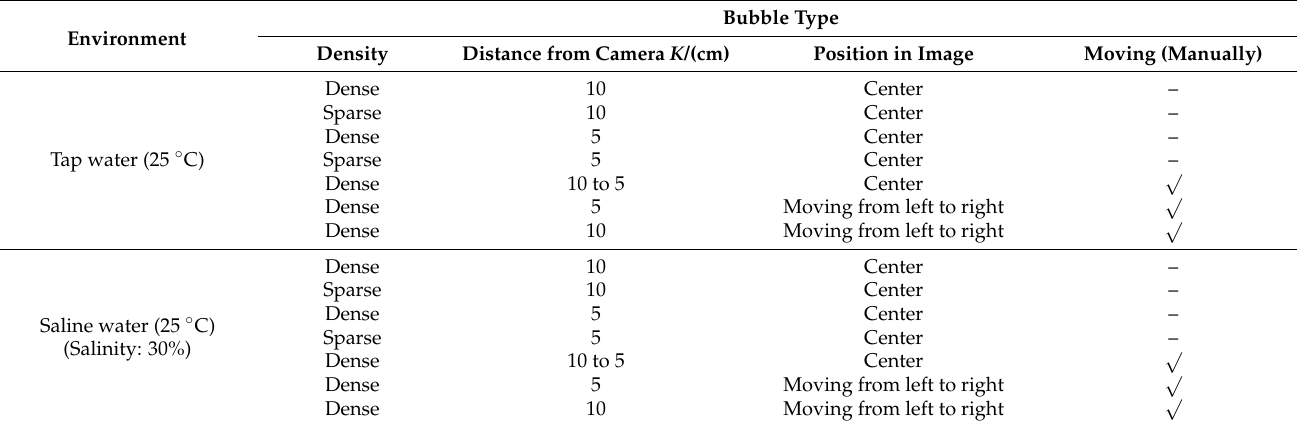
Figure 5. Schematic diagram of the bubble movement ( a ) Transverse movement. ( b ) Longitudinal movement. Table 2. Underwater environmental parameters of the